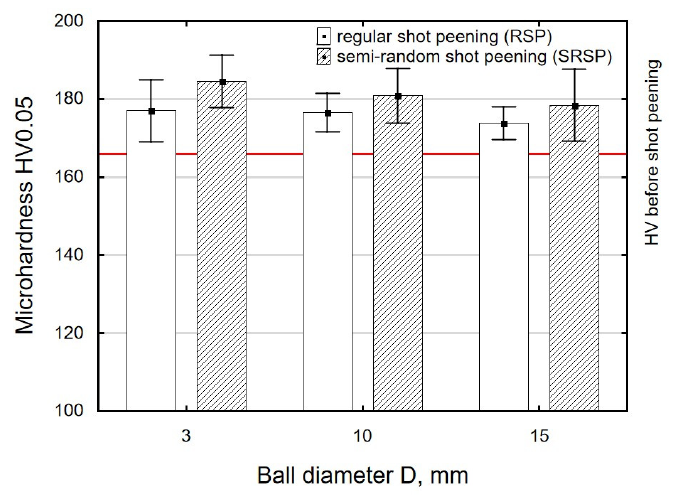
Figure 13. Peening element diameter versus surface microhardness (impact energy E = 100 mJ, distance between dimples x = 0.3 mm).